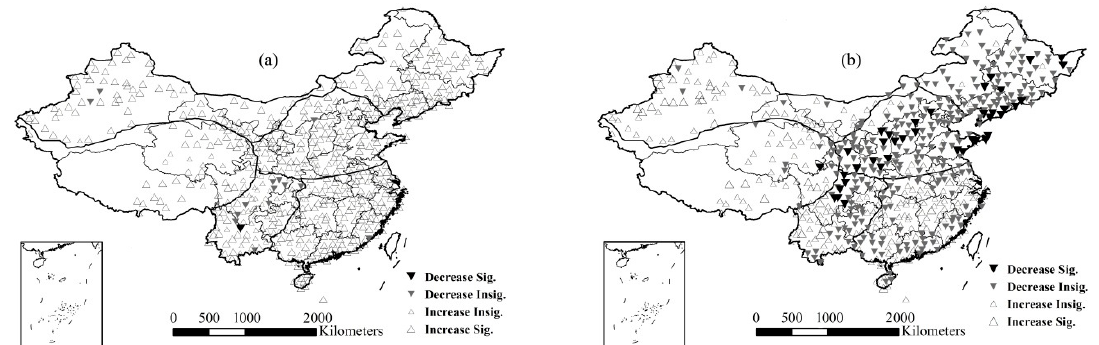
Figure 2. ( a ) Annual temperature and ( b ) precipitation trends in China identified by Mann–Kendall test [38].